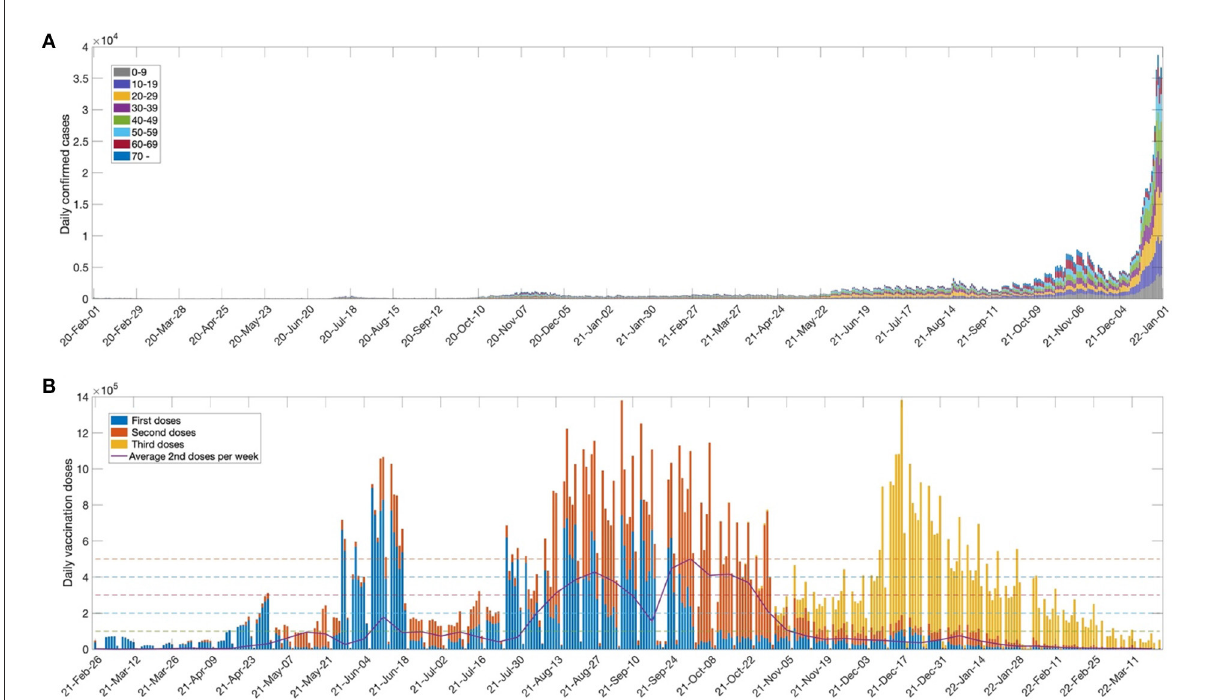
FIGURE1 (A) Number of weekly confirmed cases for age groups (0–9,10–19,20–29,30–39,40–49,50–59,60–69, 70 + ) and (B) Daily first, second and third vaccination doses. The solid curve indicates average second doses per week. The horizontal dashed lines represent daily vaccination doses ( ν = 100000, 200000, ... , 500000) used in the model